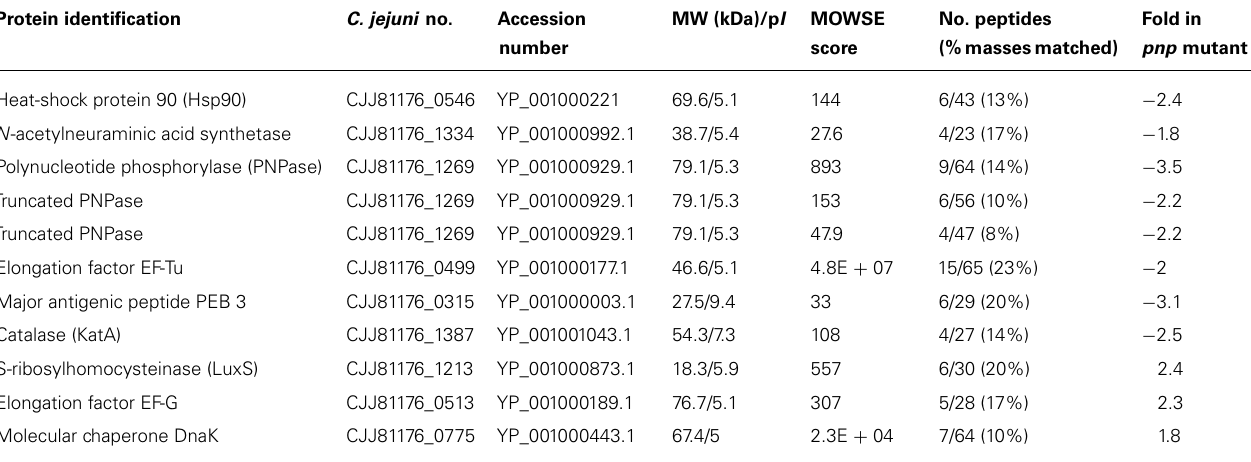
Table 3 | Campylobacter jejuni over- and down-expressed proteins in the pnp mutant as compared to the parental strain. Protein identification